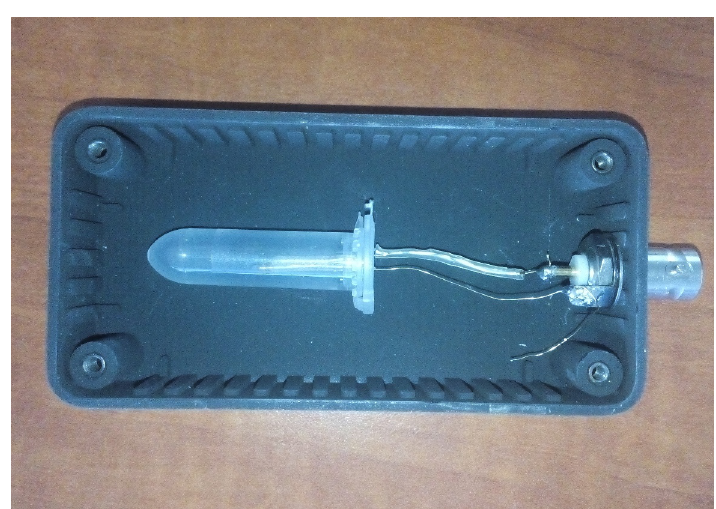
Figure 2: The diamond detector inside the plastic